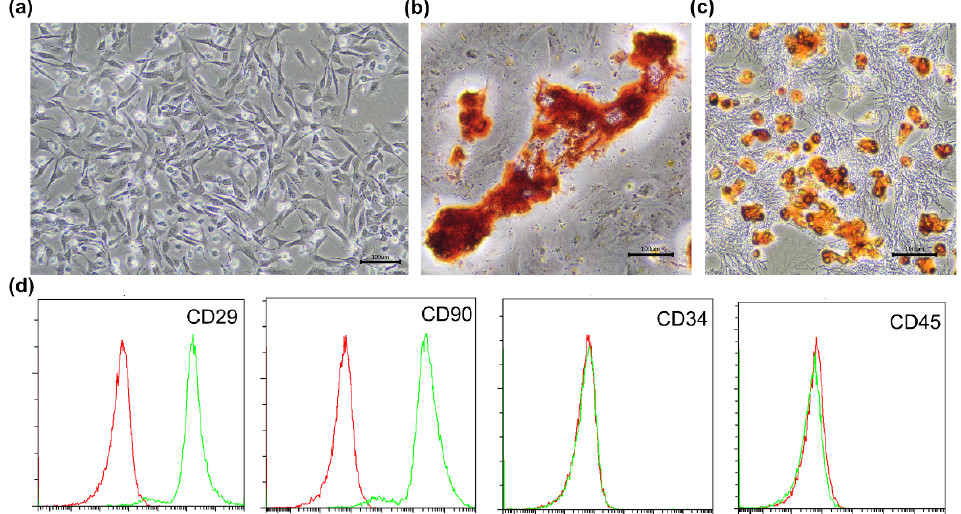
Figure 3. Identification of BMSCs. ( a ) Typical vortex distribution of BMSCs. ( b ) Alizarin red S staining revealed that osteogenic capacity of BMSCs. ( c ) Oil Red O staining showed adipogenic differentiation of BMSCs. ( d ) Expression of BMSCs surface markers CD29, CD34, CD44, and CD90 detected by flow cytometry. Red lines indicated the blank control BMSCs, and green lines indicated the antibodies-bound BMSCs.